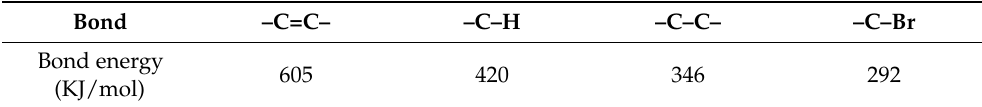
Figure 2. TG and DTG curves of BIIR in air at different heating rates: ( a ) 0.5 °C min −1 , ( b )1 °C min −1 , ( c ) 2 °C min −1 , ( d ) 5 °C min −1 , ( e ) °C min −1 , and ( f ) 20 °C min −1 . Table 2. Bond energies in Table 1. Decomposition temperatures (T pi /°C) of BIIR at different heating rates in air.